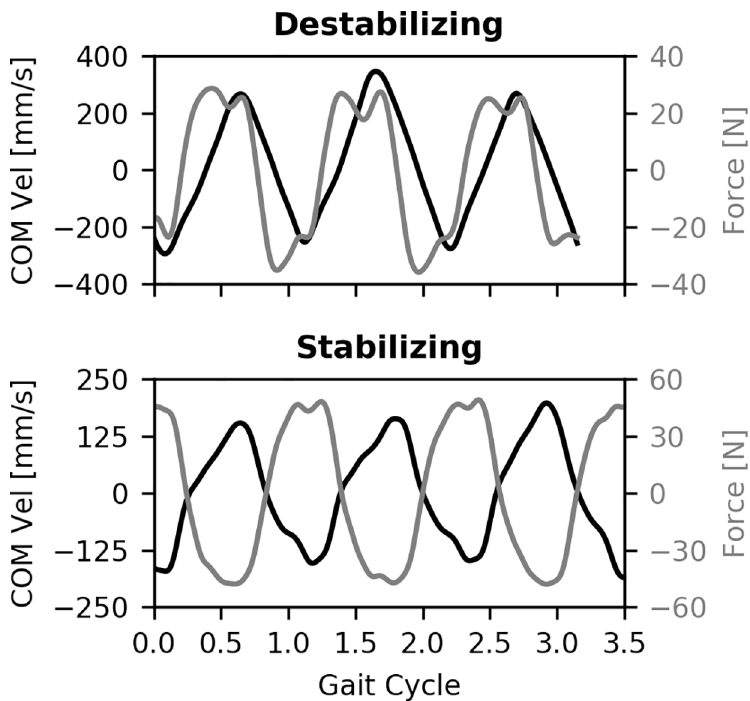
Fig 3. Perturbation force timing. COM velocity (black line) and net applied force (grey line) from three consecutive gait cycles in the perturbation block from a single participant. The applied force was in phase with the COM velocity during the destabilizing perturbations, and 180˚ out of phase with COM velocity for the stabilizing perturbations.